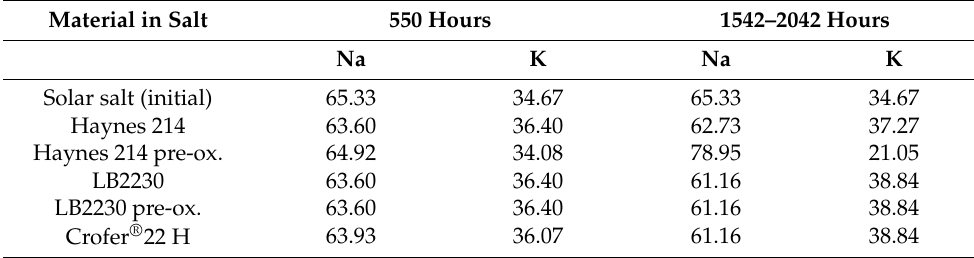
Table 4. Molar contents of Na and K in solar salt after 550 h and after 2042 h of discontinuous corrosion testing at 600 ◦ C. Analysis by FZ Jülich,